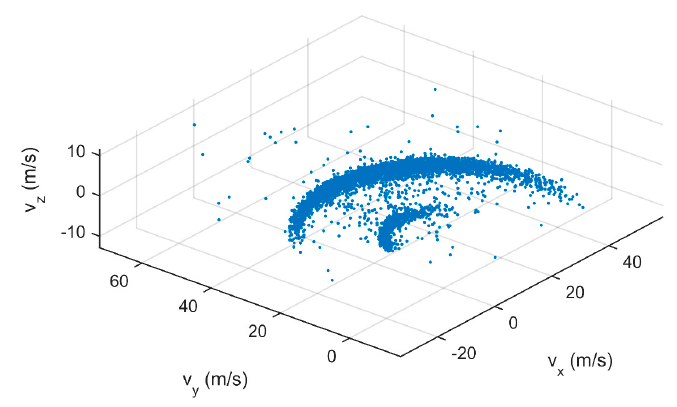
Figure 7. Particle 3D velocity components expressed in spreader coordinate system. The spreader was set at configuration B.